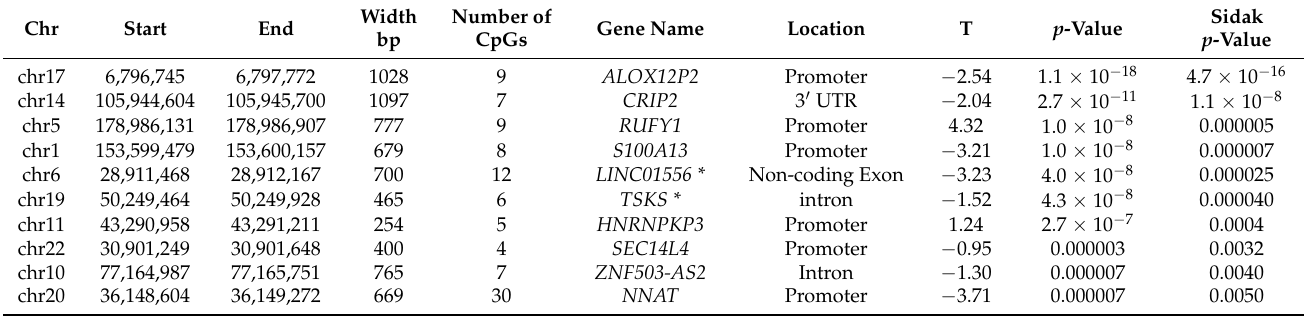
Table 3. Top 10 of differentially methylated regions (DMRs) in maternal PBMCs associated with IgE sensitization to airborne allergens in children at 5 years.